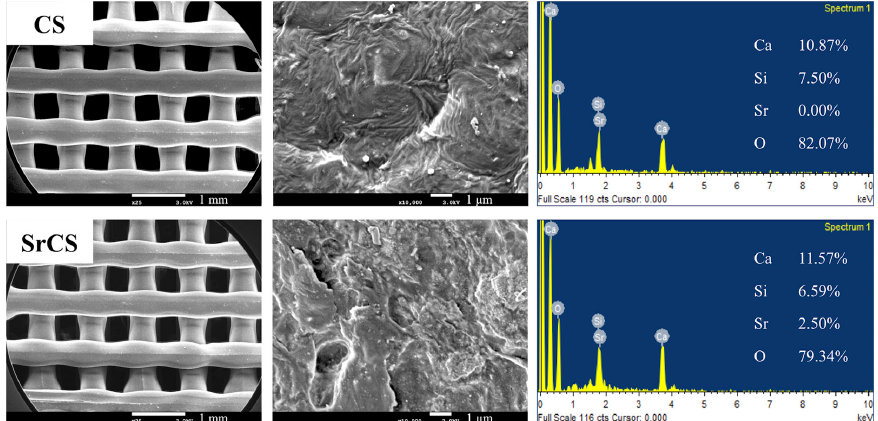
Figure 2. X-ray di ff raction patterns of CS and SrCS sca ff olds. Figure 2. X-ray diffraction patterns of CS and SrCS scaffolds.